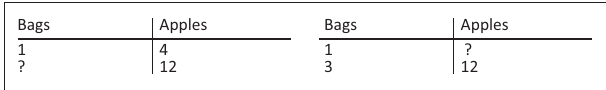
FIGURE 2: T- tables for related division problems.